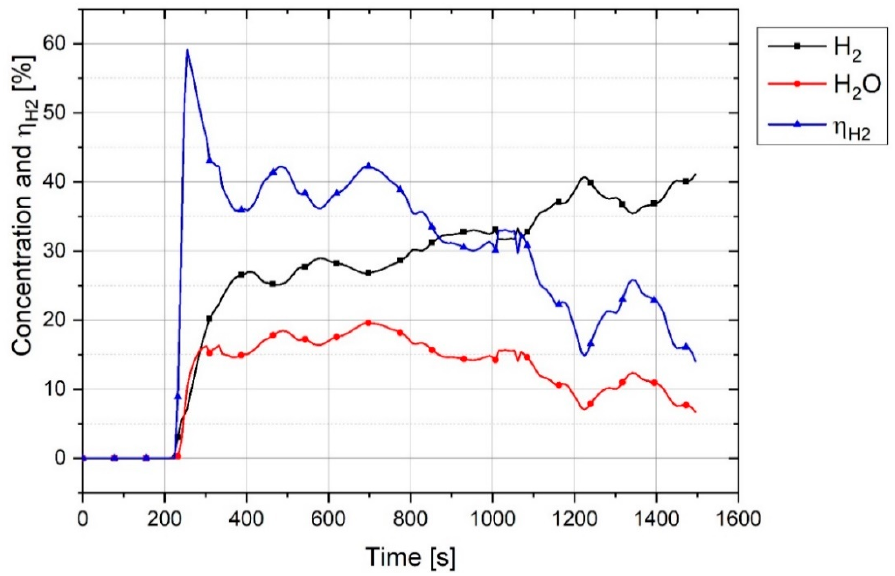
Figure 12. H 2 and H 2 O concentration in off-gas and η H